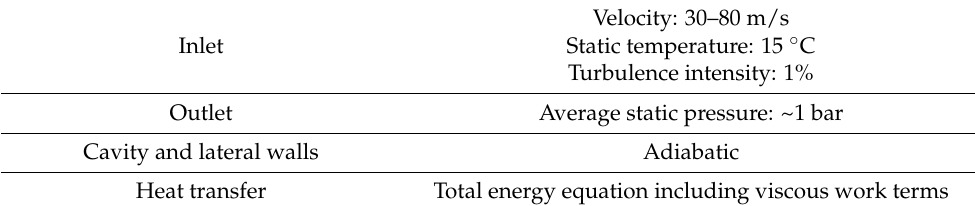
Table 1. Applied boundary conditions.